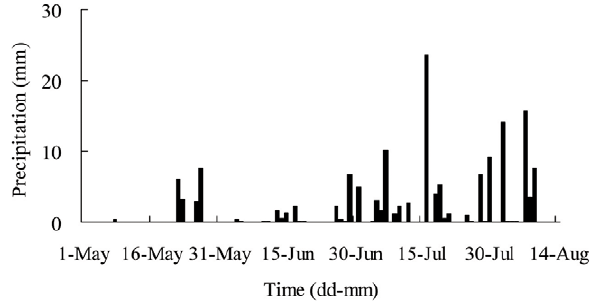
Figure 1. Daily precipitation before field survey (from May 1 to August 10) in 2009 at Qinghai Gonghe Desert Ecosystem Research Station.